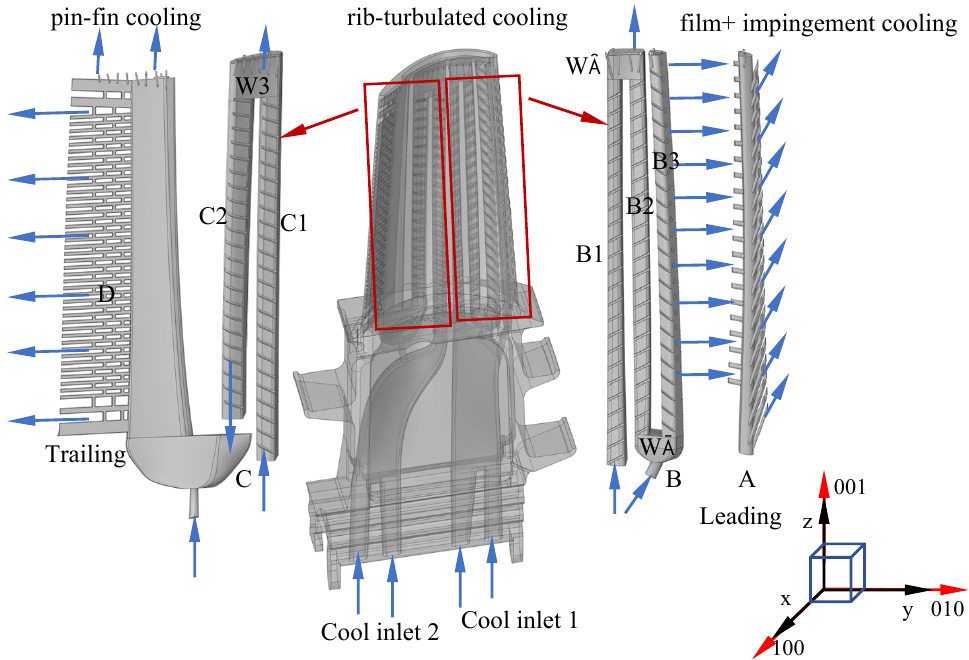
Figure 1. The cooling structure schematic of a high-temperature Ni-based superalloy turbine ro- tor blade: W1–W3 indicate 180 ◦ turns in the serpentine passages; A–D indicate the different cool- ing